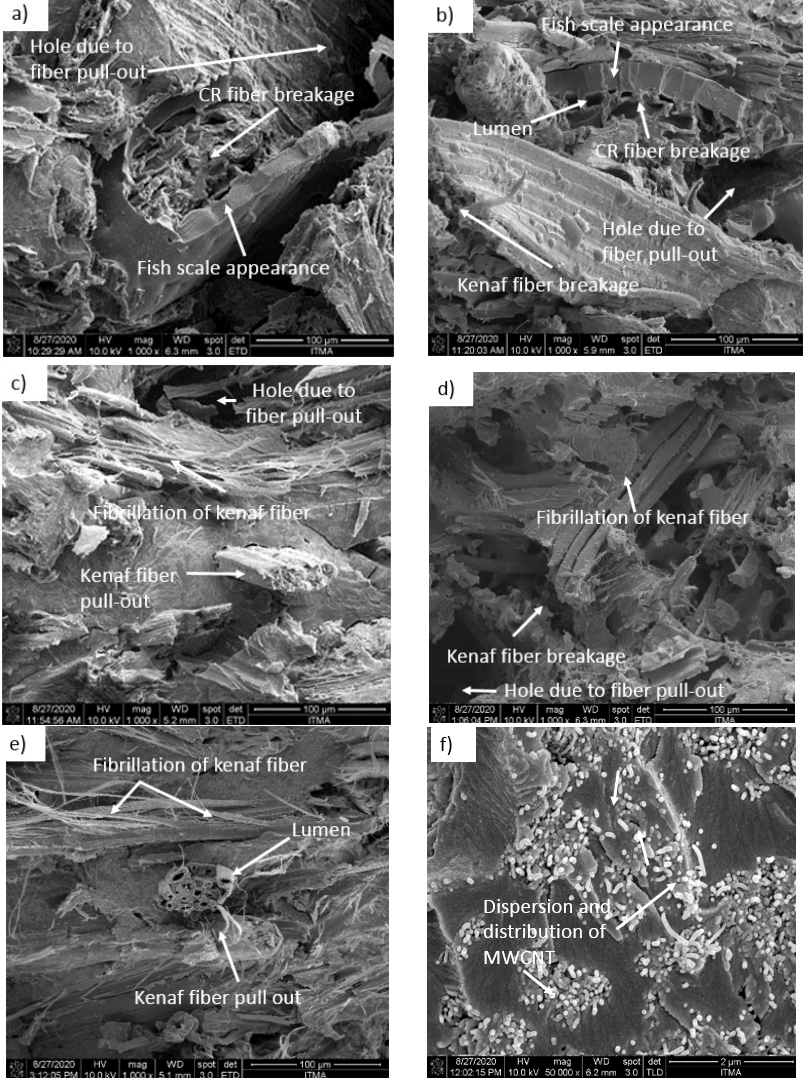
Figure 5. FE-SEM images of tensile fractured specimens of ( a ) 10C:0K, ( b ) 7C:3K, ( c ) 5C:5K, ( d ) 3C:7K ( e ) 0C:10K composites at magnification of ×1000, ( f ) 10C:0K composites at magnification of ×50,000.